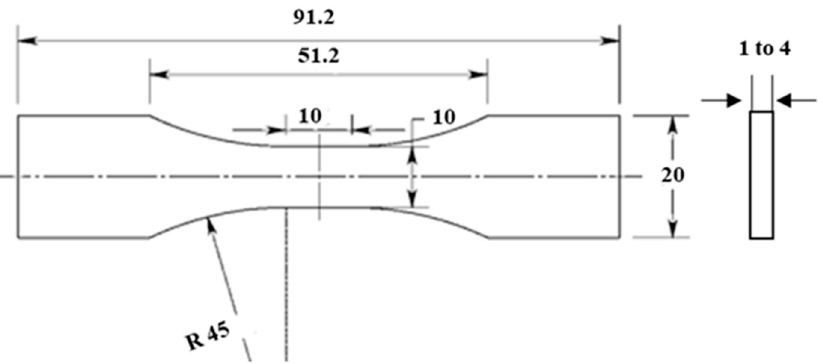
Figure 1. Flat specimen geometry used for tension tests. Dimensions are in mm.